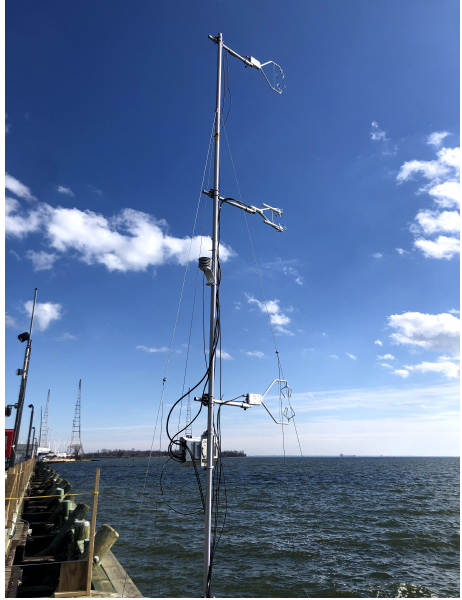
Figure 2. The sensor array overlooking the Severn River and the Chesapeake Bay.